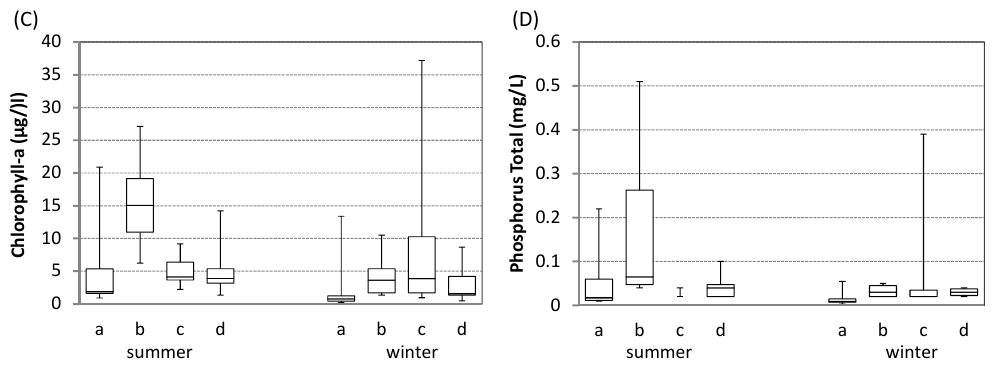
Figure 2. Measured concentrations ( A ) dissolved oxygen; ( B ) total nitrogen; ( C ) chlorophyll-a, and ( D ) total phosphorus along the SSR, ( a ) uSSR at Medicine Hat; ( b ) uSSR at Leader; ( c ) lSSR at Outlook, and ( d ) lSSR at Clarkboro Ferry.